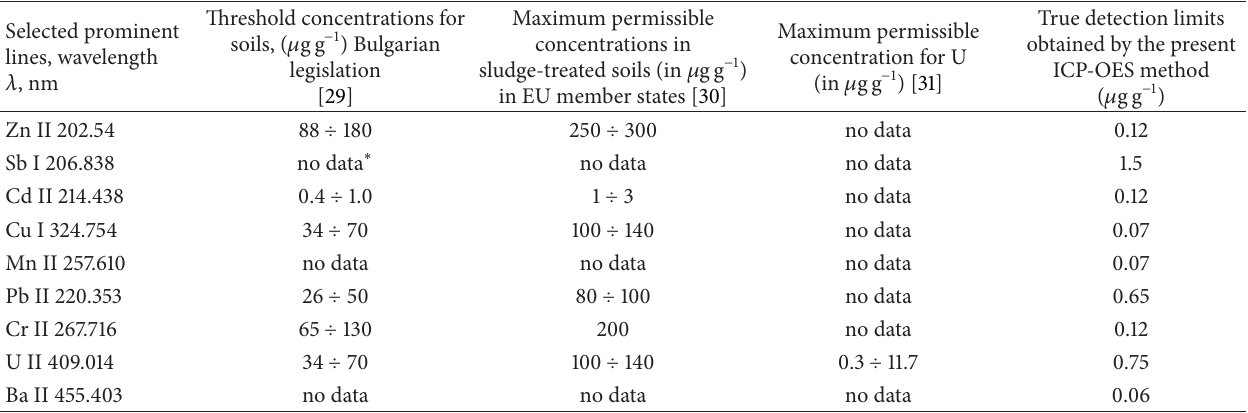
Table 5: Threshold concentrations in the determination of Zn, Sb, Cd, Cu, Mn, Pb, Cr, U, and Ba in soil ( 𝜇 gg − 1 ) [29] (column 2) and the maximum permissible concentrations of potentially toxic elements in sludge-treated soils ( 𝜇 gg − 1 dry soil) in EC member states and US [30] (column 3), maximum permissible concentrations for U [31] (column 4), and true detection limits obtained by the present ICP-OES method ( 𝜇 gg − 1 ) (column